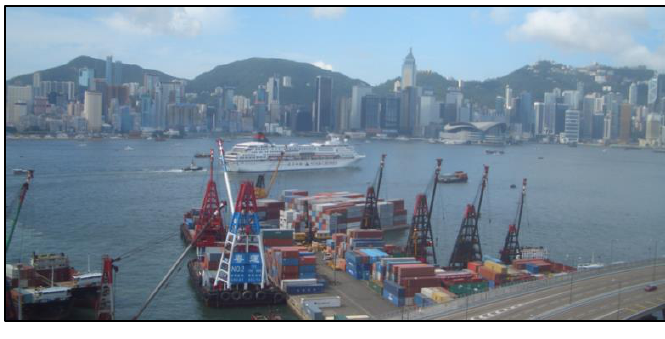
Figure 2: Traditional midstream wharf in Hong Kong